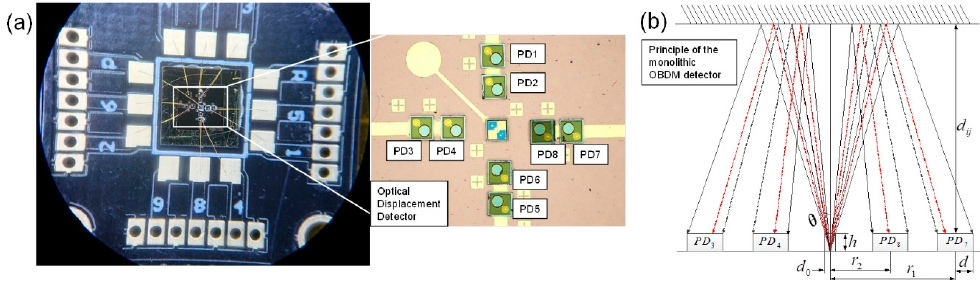
Figure 4. OBDM detector and its working principle. ( a ) The layout of the PDs and VCSEL; ( b ) Schematic of the principle of the monolithic OBDM detector.